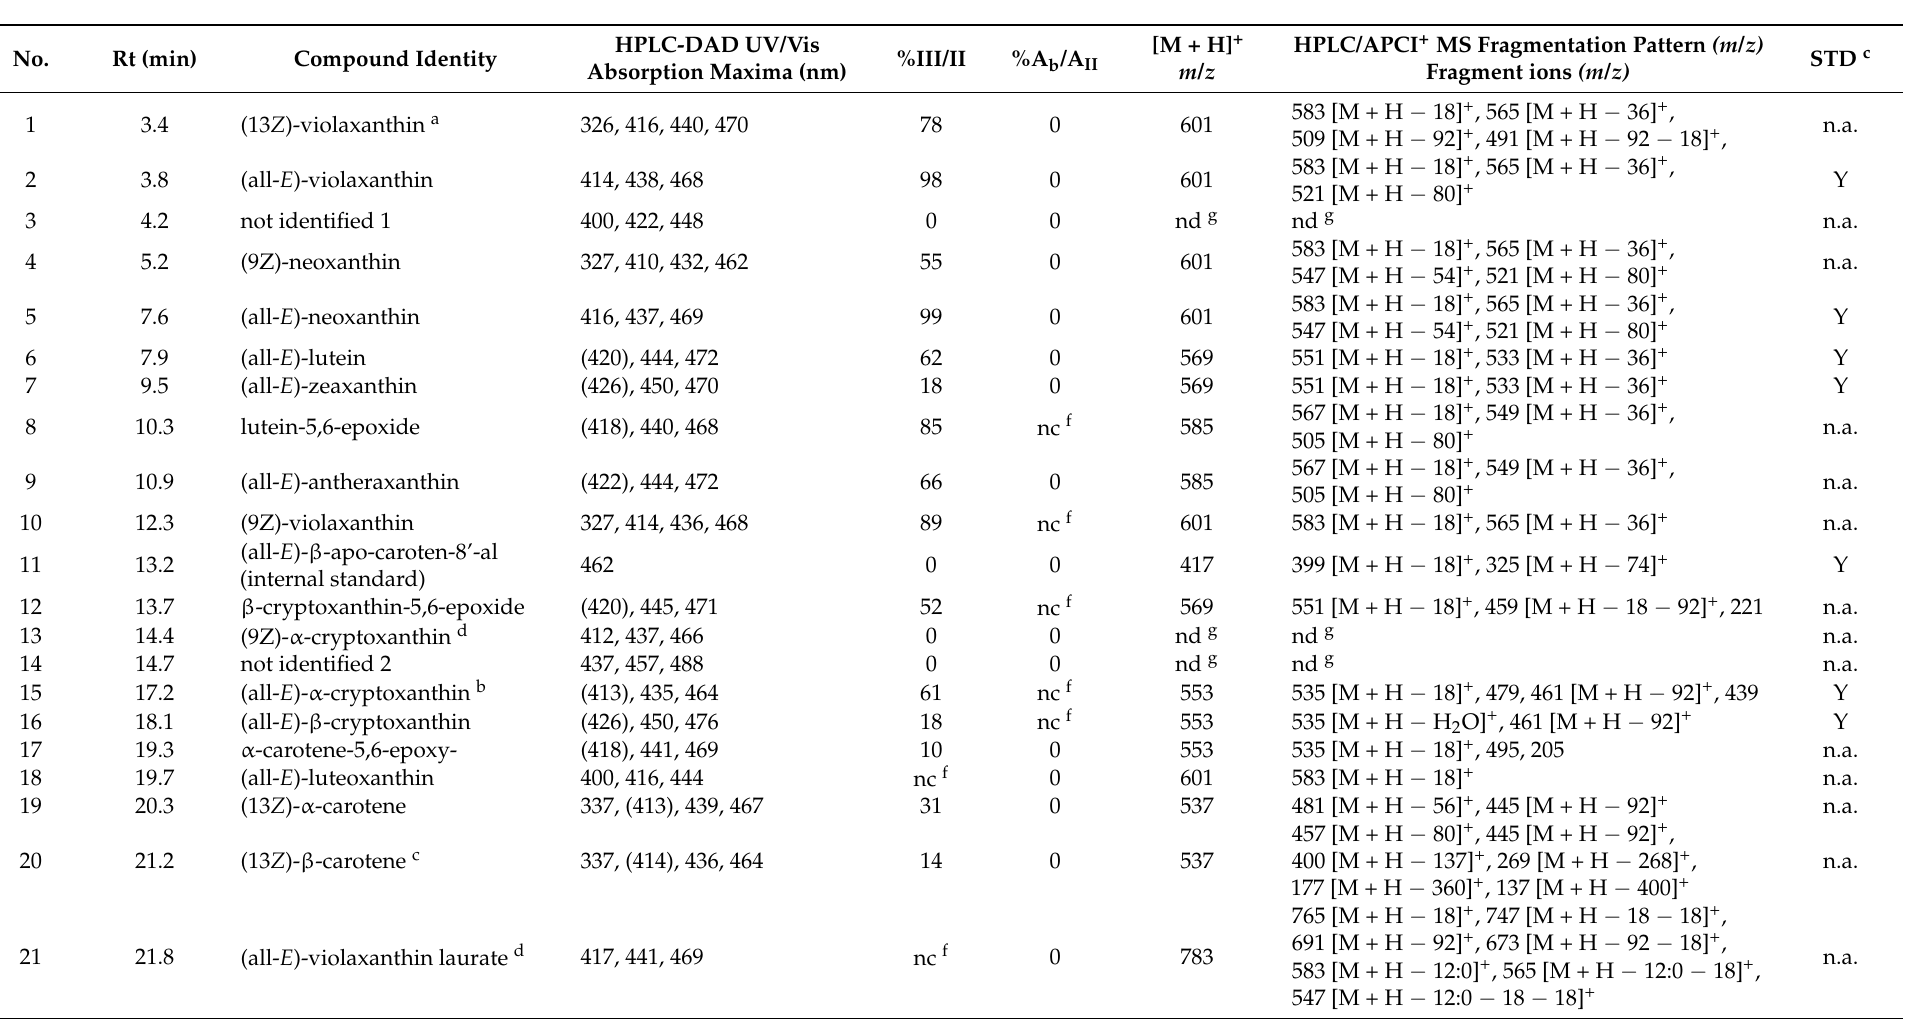
Table 2. HPLC retention times, ultraviolet (UV)/visible light (Vis) spectra, and MS spectral data of carotenoids from papaya ( Carica papaya L.) pulp and peel of Sweet Mary, Alicia, Eksotika, and Maradol